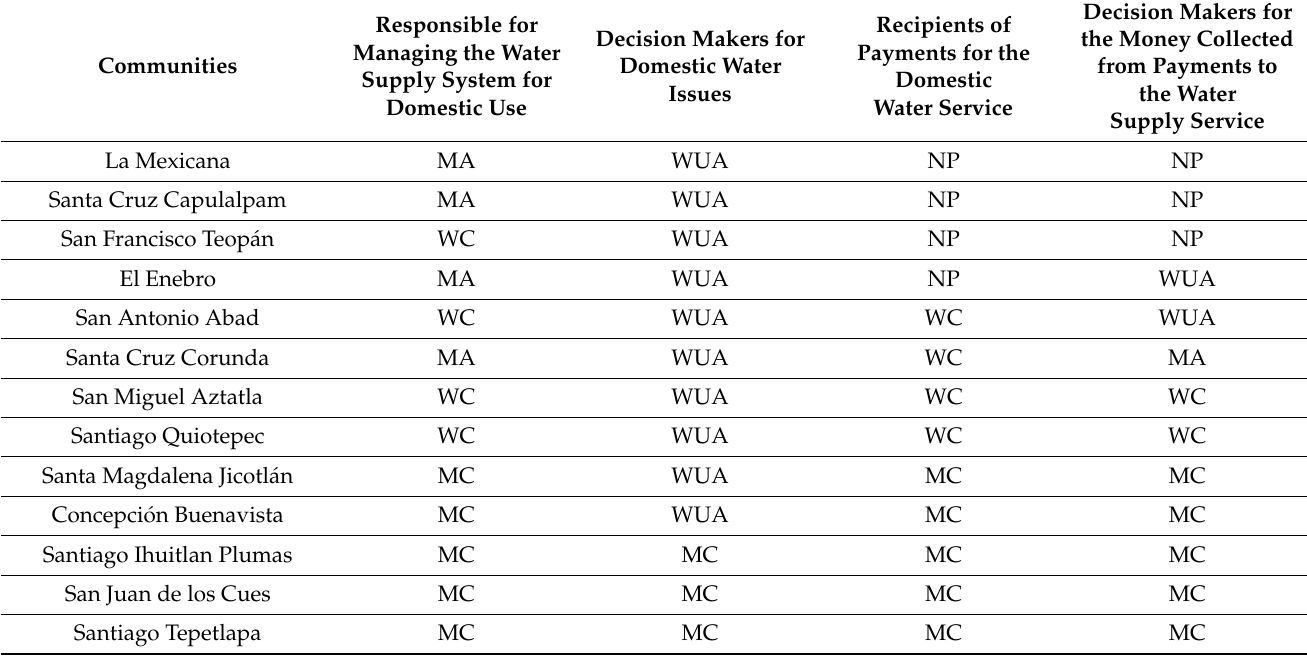
Table 2. Stakeholders identified by the survey administered in the 13 rural communities. The questions correspond to the first (operability) and second (institutional arrangement) orders of the Interactive Governance Framework (IGF) [14]. NP = no payment for water services, MA = municipal agent, WC = water committee, MC = municipal council, WUA = water users